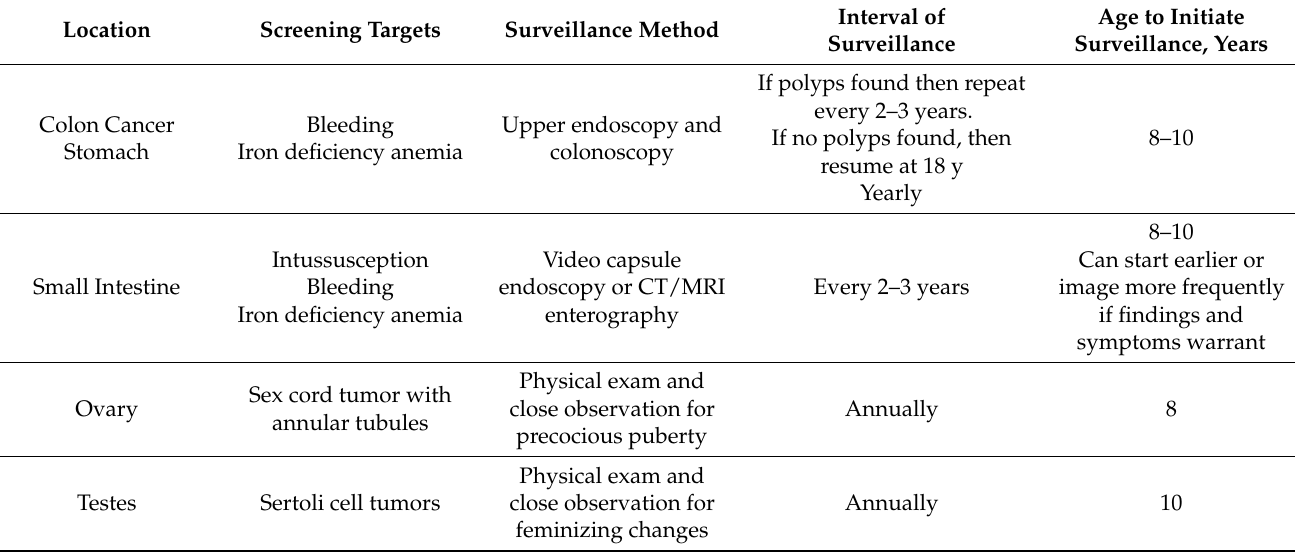
Table 3. NCCN pediatric surveillance